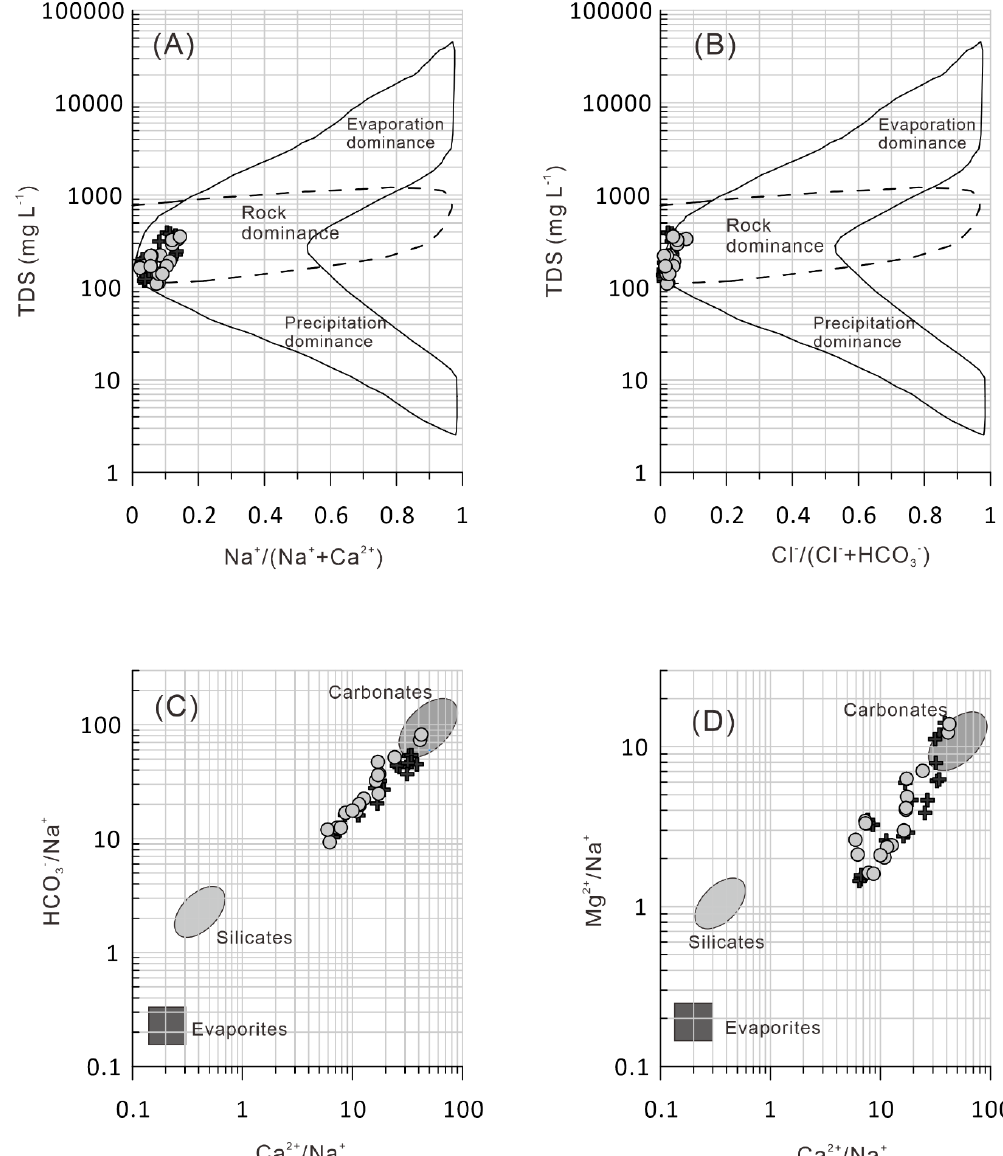
Figure 3. Gibbs plots ( A , B ) and mixing diagrams ( C , D ) for the river water samples from the Issyk − Kul Basin. The grey dots correspond to the period with low river flow ( n = 19 ) and the black crosses correspond to the period with high river flow ( n = 19 ).